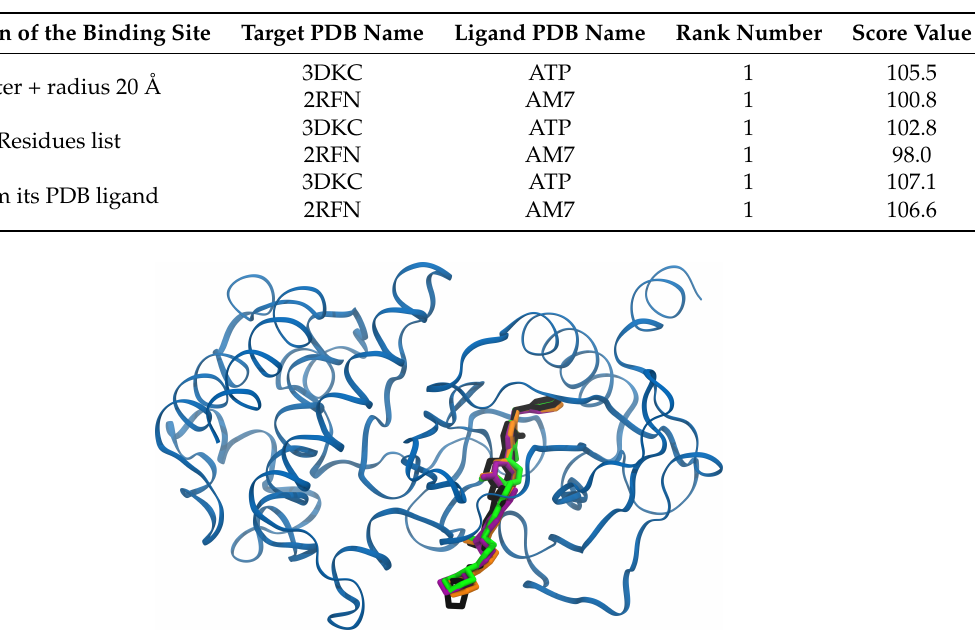
Table 5. Comparison of the docking results using the 3 binding site definitions.